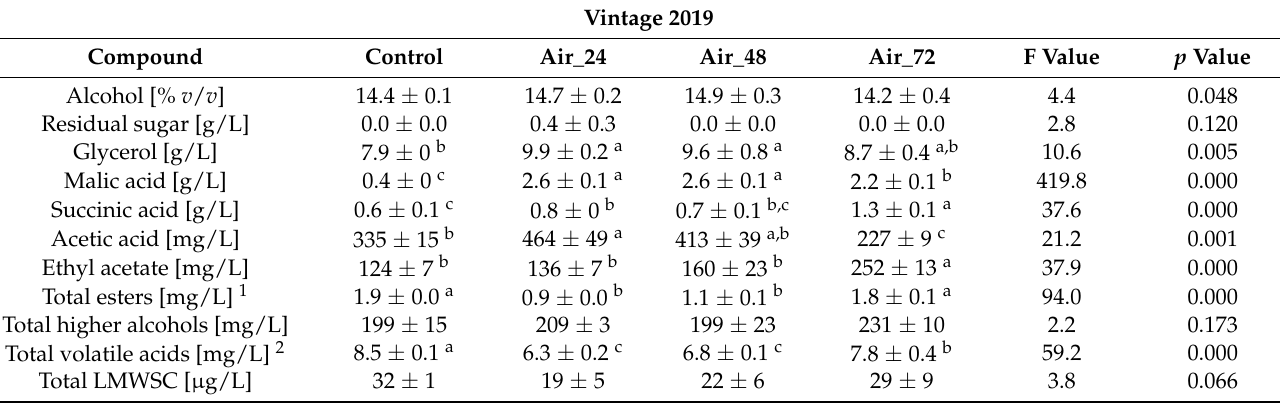
Table 1. Post-fermentation chemical composition for vintage 2019 wines.